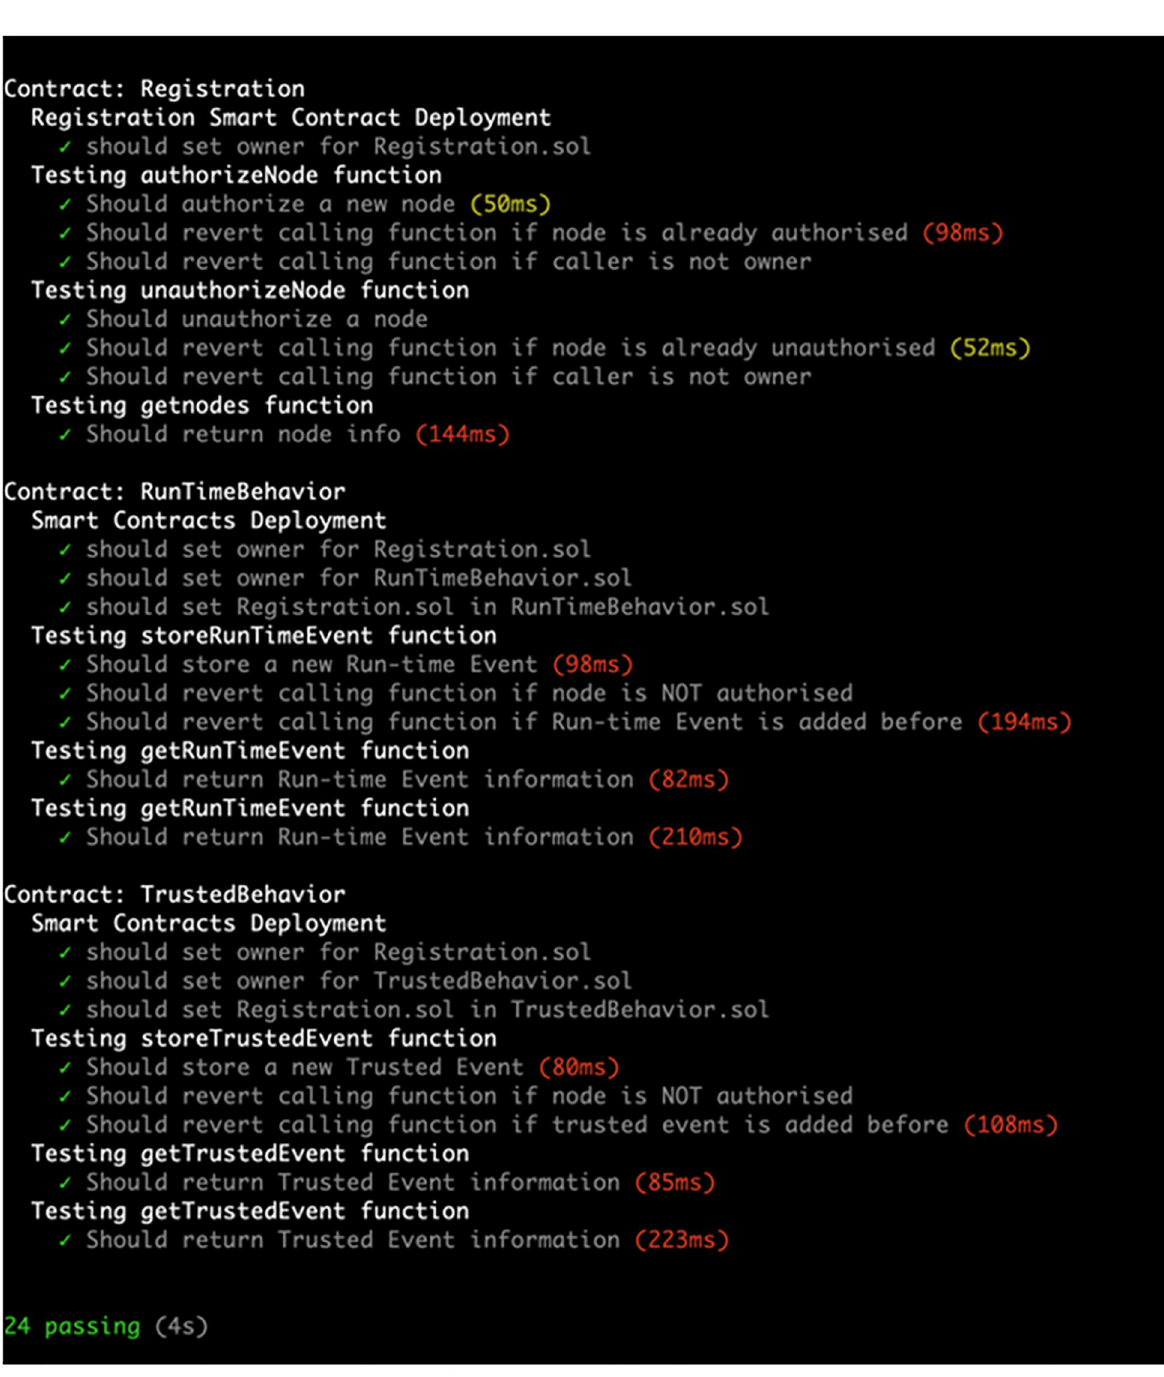
We created a test module for each Transaction and Query operation. To reduce the likelihood of errors due to system overload and network congestion, tests were performed in multiple rounds with a fixed number of transactions and different send rates. We measured the latency and throughput for both operations Transaction and Query by changing the send rate from 100